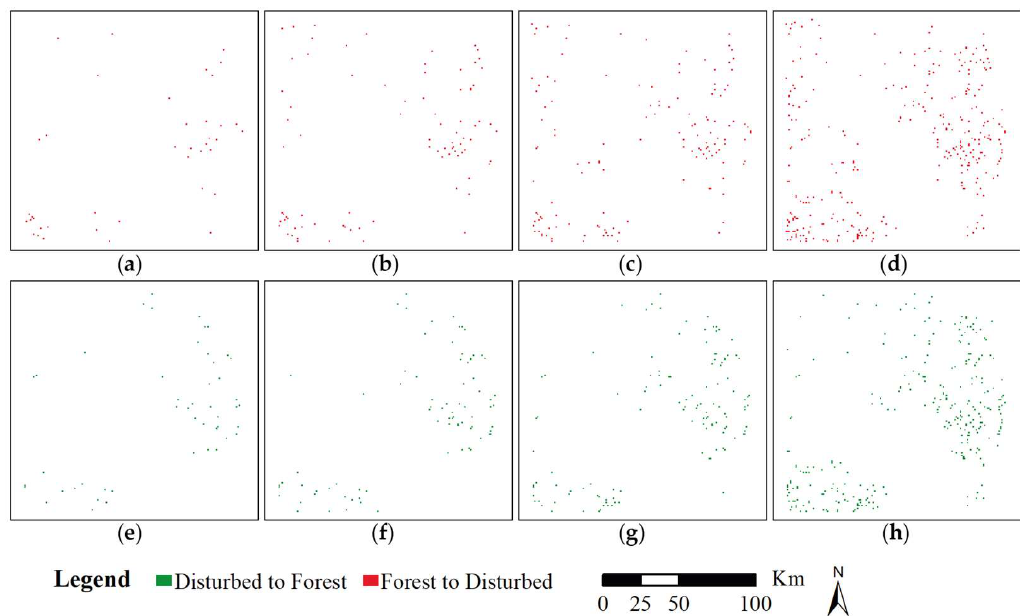
Figure 7. Annual carbon emissions due to land use change.